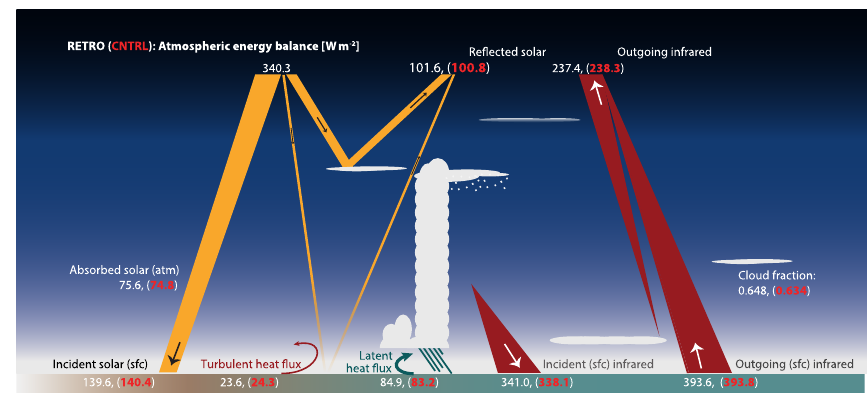
Figure 6. Globally averaged energy budget contributions for RETRO and CNTRL.